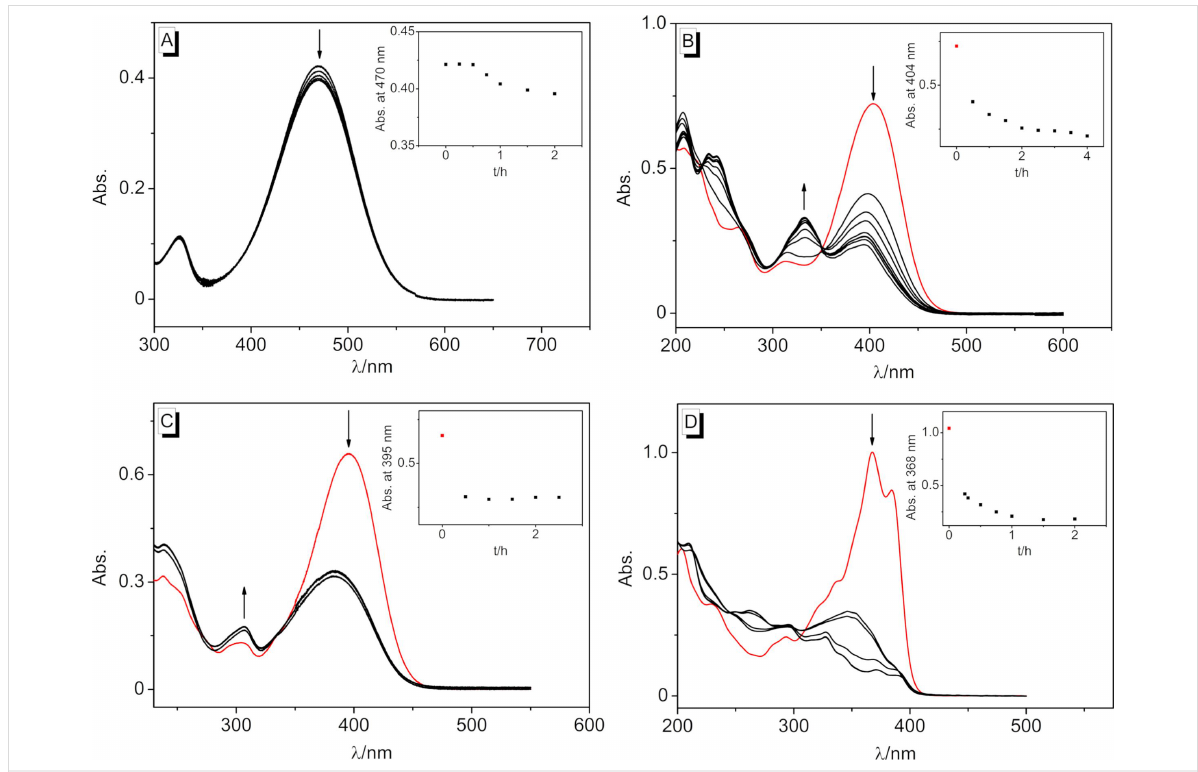
Figure 5: Spectrophotometric monitoring of the irradiation of styrylquinolizinium derivatives 3a (A), 3b (B), 3c (C), and 3d (D) in acetonitrile [ c L = 10 µM (A), c L = 20 µM (B, C, D)]. The arrows indicate the changes of absorption upon irradiation.